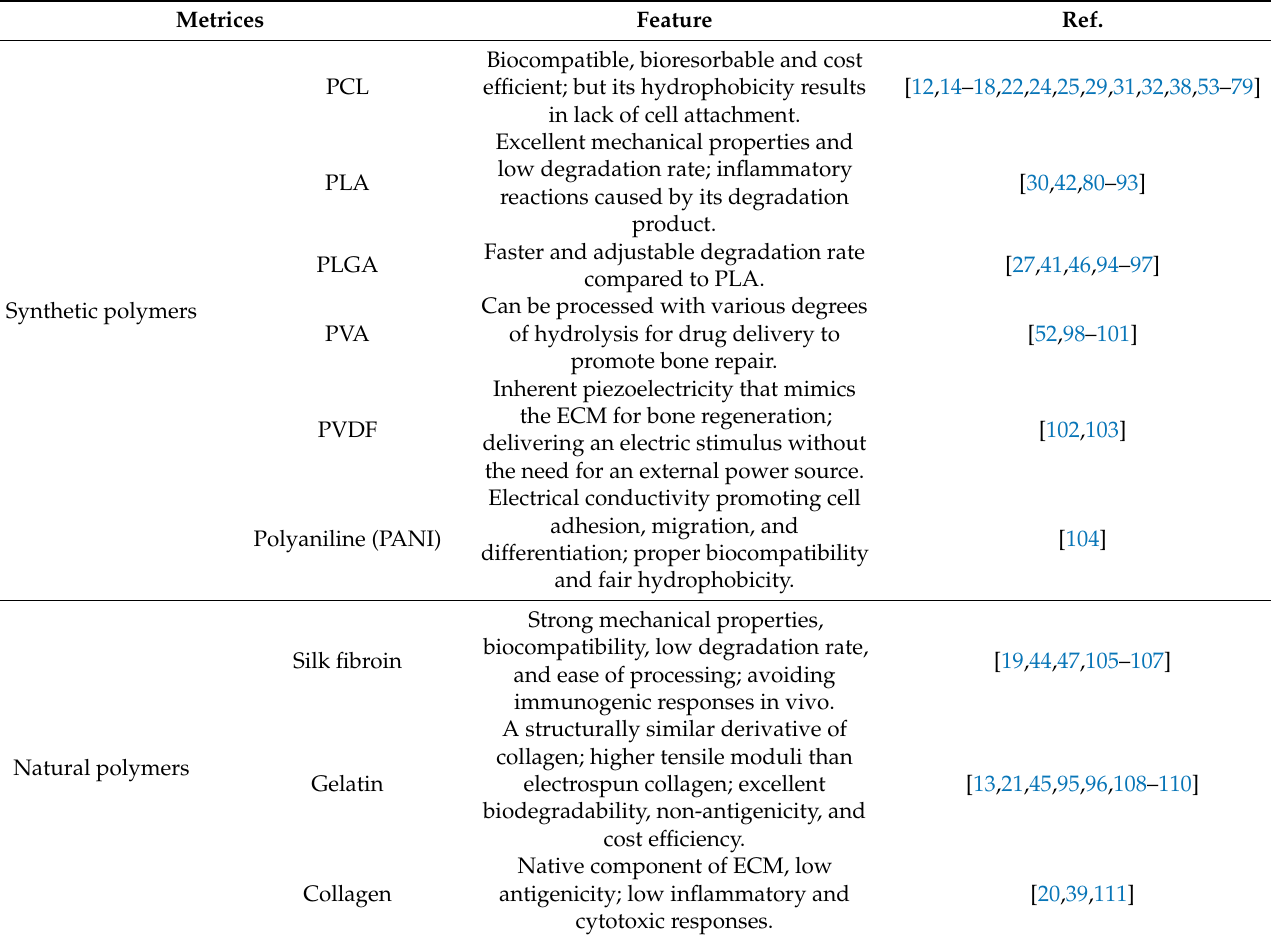
Table 2. Examples of electrospun polymeric metrices used in